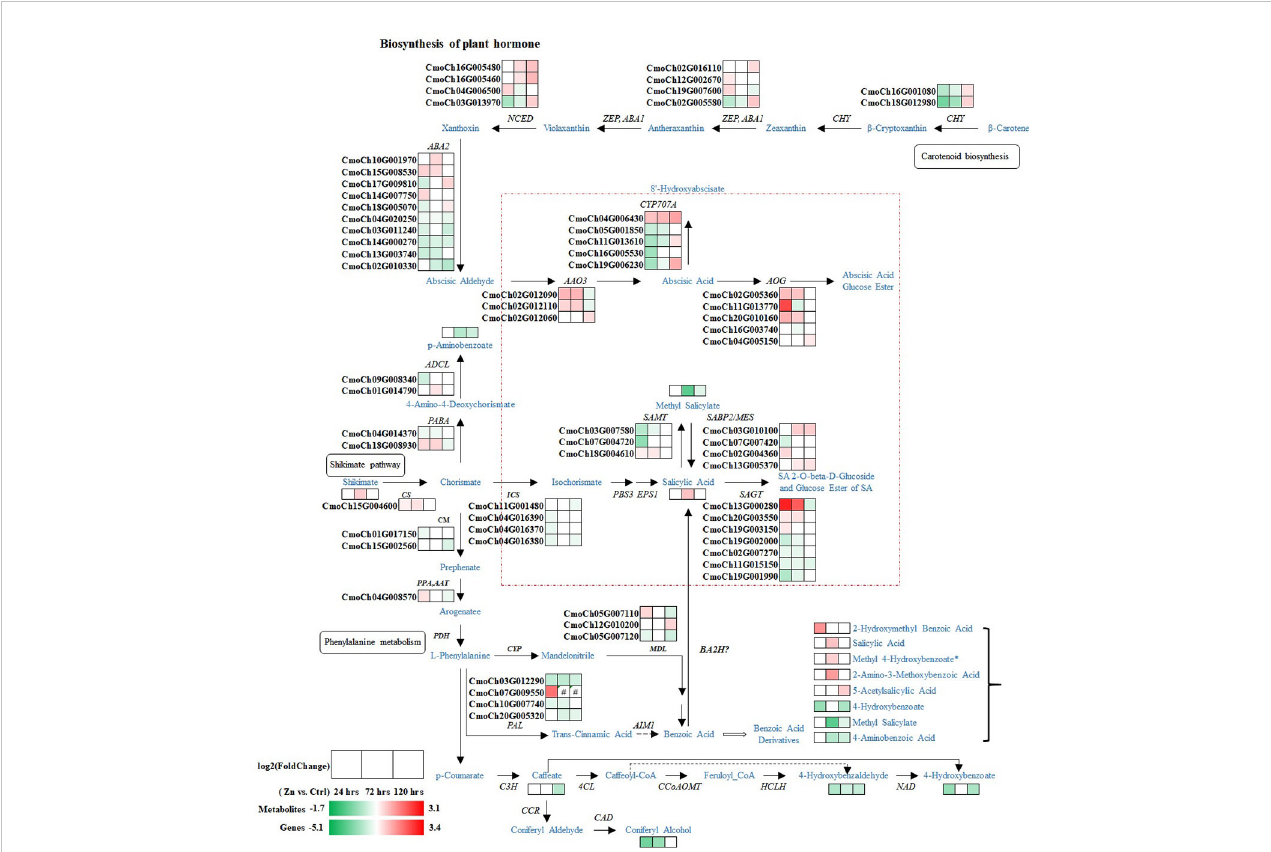
FIGURE 5 Possible biosynthesis routes for the biosynthesis of ABA and SA in the pumpkin. Blue and black colours are metabolites and genes involved in the pathway, respectively. The regulations of metabolites and genes by Zn treatments at different time-points compared to the control were demonstrated by the heatmap. Red and green colours represent the increase and decrease in abundance of metabolites or genes. The red box displays the potential core network in which relevant molecules were regulated by Zn and hence resulted in changes of ABA and SA biosynthesis in pumpkin leaves. Enzymes are abbreviated as follows: CHY carotene 3-hydroxylase [EC:1.14.15.24]; ABA1 zeaxanthin epoxidase [EC:1.14.15.21]; NCED 9-cis-epoxycarotenoid dioxygenase [EC:1.13.11.51]; ABA2 xanthoxin dehydrogenase [EC:1.1.1.288]; AAO3 abscisic aldehyde oxidase [EC:1.2.3.14]; AOG abscisate